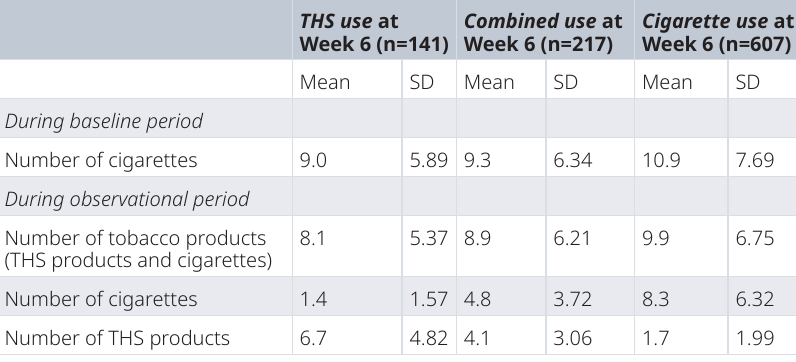
THS use at Combined use at Week 6 (n=141) Week 6